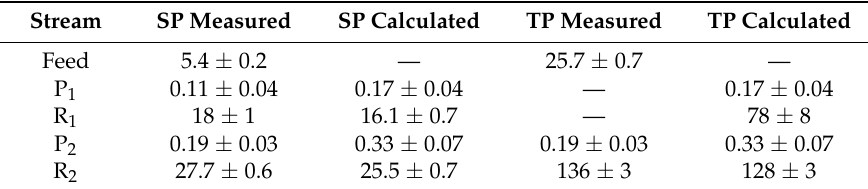
Table 3. Calculated and measured mixing-cup concentrations (g L − 1 ) of serum protein (SP) and true protein (TP) for the 100 kDa charged membrane during the six-fold volume concentration of skim milk. The streams are feed, first stage permeate (P 1 ) and retentate (R 1 ), and second stage permeate (P 2 ) and retentate (R 2 ).